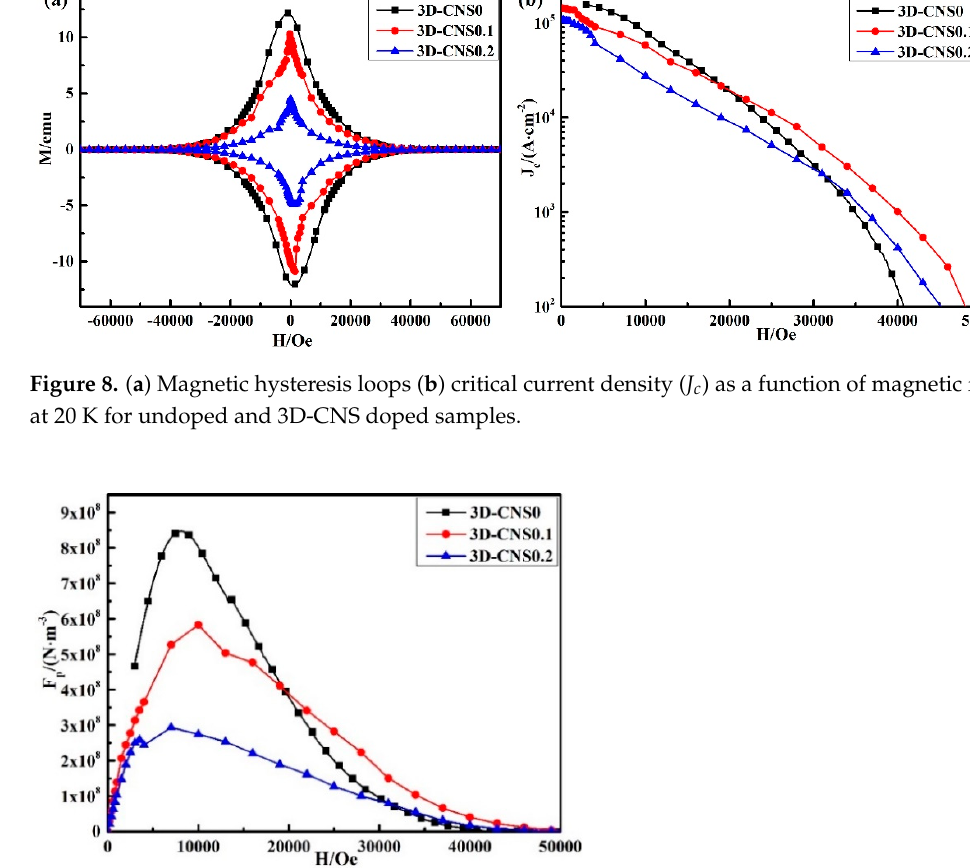
Figure 8. ( a ) Magnetic hysteresis loops ( b ) critical current density ( J c ) as a function of magnetic field at 20 K for undoped and 3D-CNS doped samples.